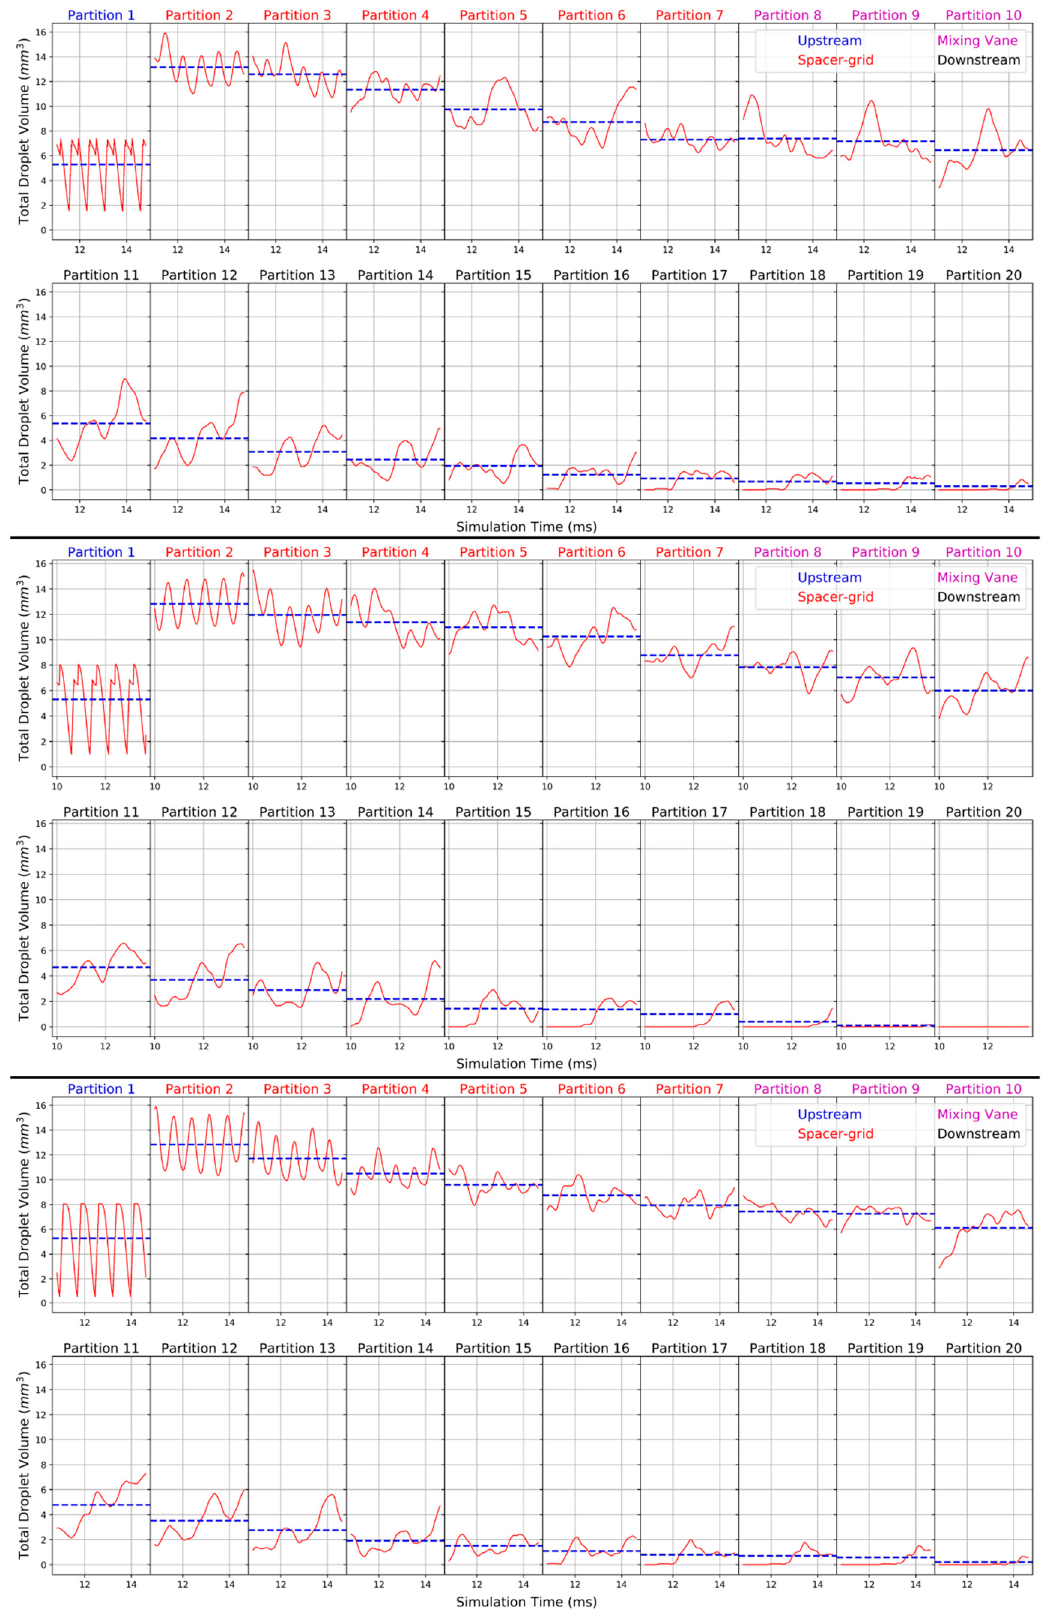
Figure 16. Axial evolution of total droplet volume in partitions for We40, We55 and We80 ( top – bottom ) water–steam system cases.